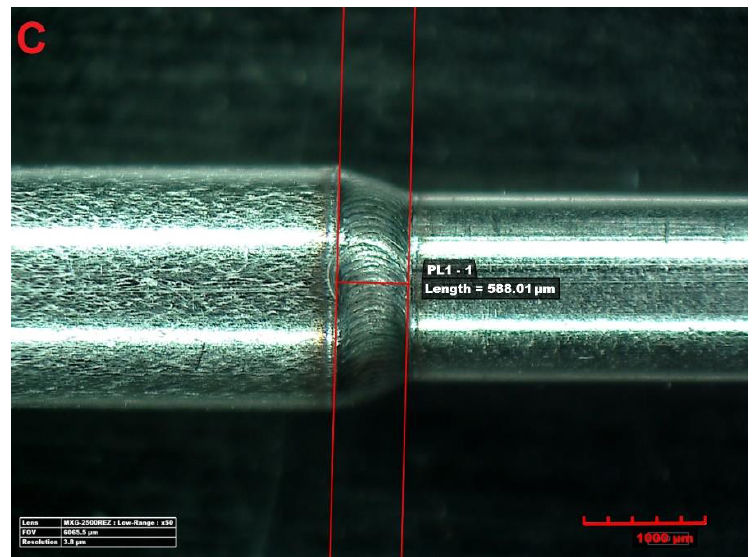
Figure 1. Example view of analysed welds: ( A ) lap–butt weld of the probe tip with a tube-shaped probe body; ( B ) lap joint of two tubes; ( C ) fillet joint of two tubes.